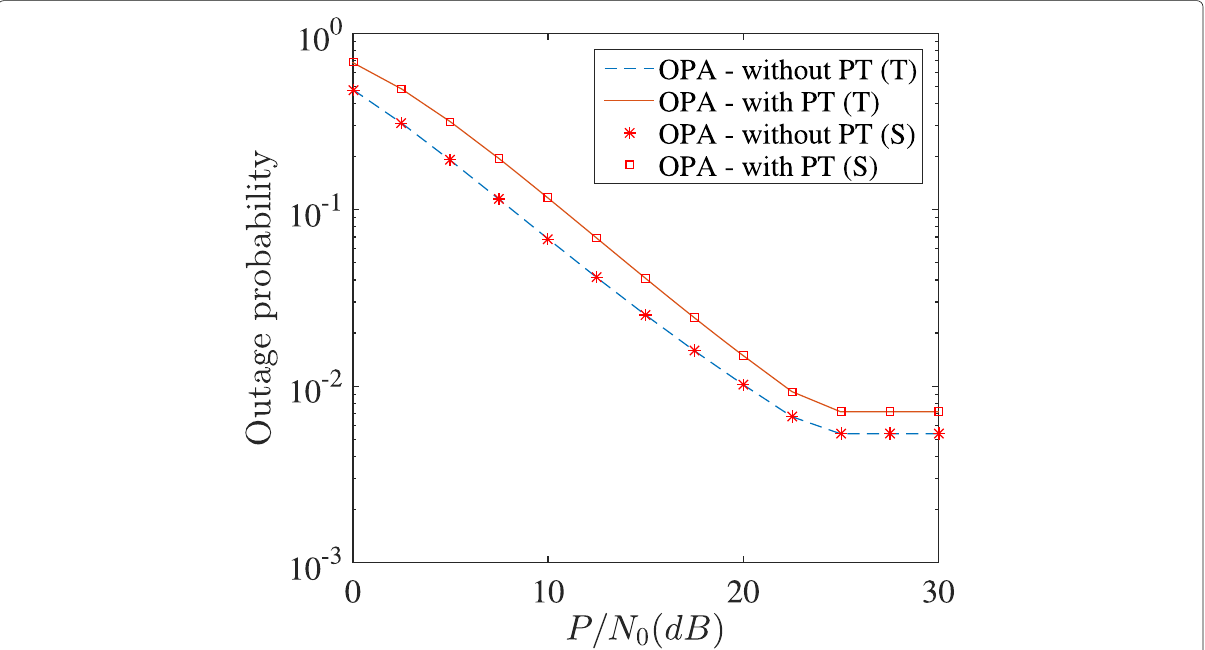
Fig. 12 Outage probability comparison with and without interference from PT; P PT / N 0 = 10